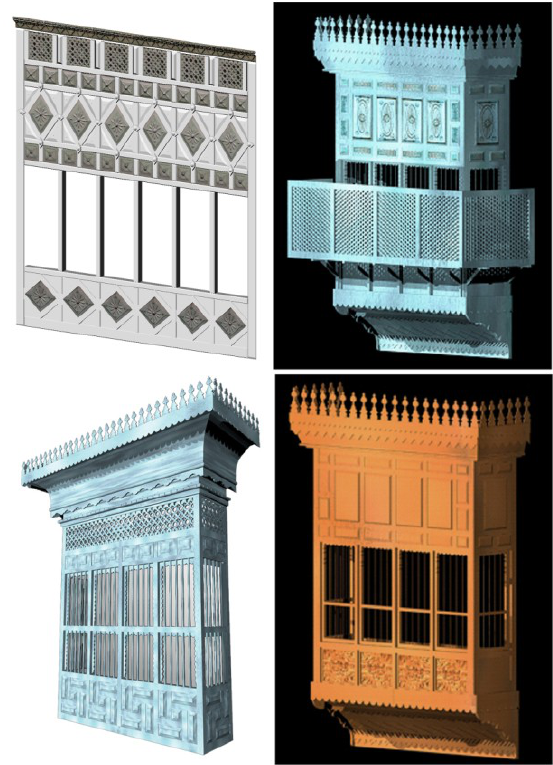
Figure 11.Final 3D textured